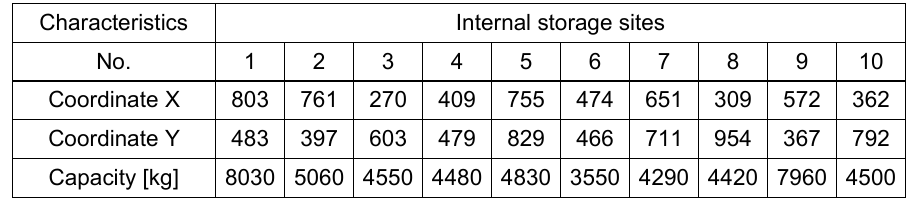
Table 1 – Characteristics of potential internal storage sites (Dimitrijevi ć et al., 2013) Таблица 1 – Характеристики потенциальных внутренних местоположений для складирования (Dimitrijevi ć et al.,